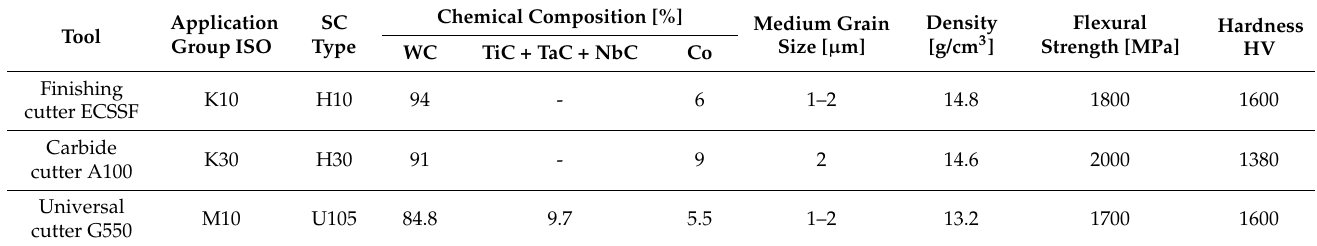
Table 3. Material properties of tools.